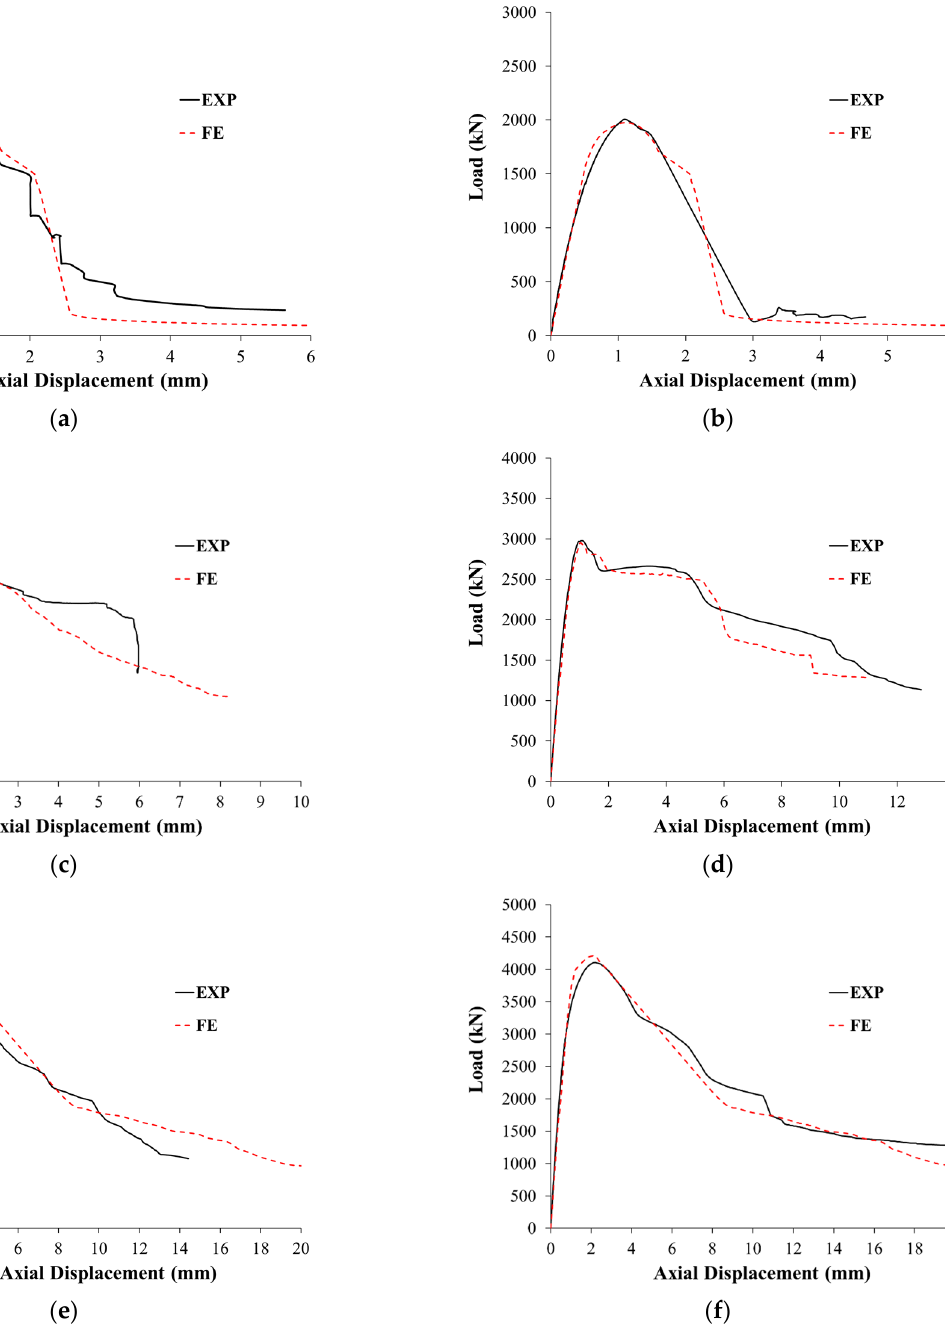
Figure 19. Experimental versus FE load–displacement plots for tested columns: ( a ) C1; ( b ) C2; ( c ) S1; ( d ) S2; ( e ) S3; ( f ) S4.